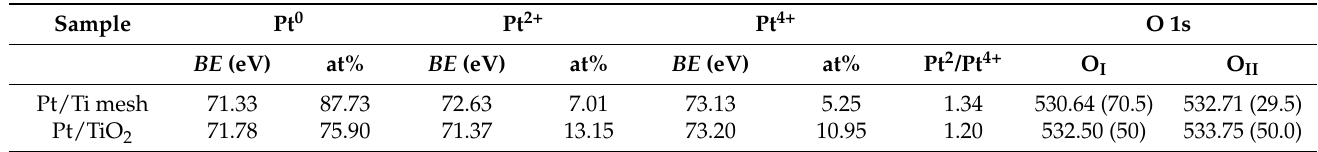
Table 2. XPS fitting parameters from the core-level spectra of Pt 4f and O